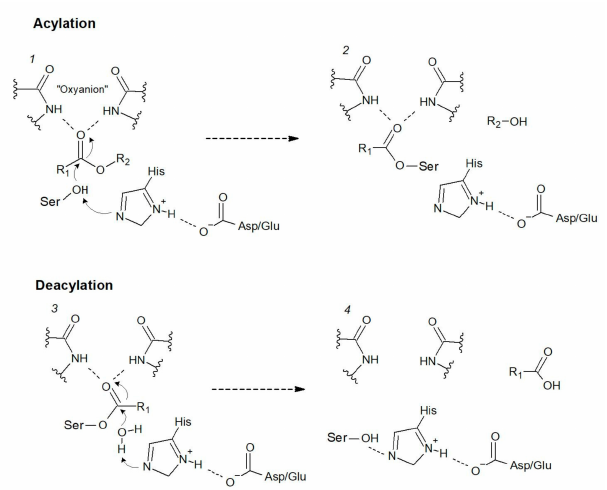
Figure 2. Schematic representation of the mechanism of hydrolysis reactions catalyzed by lipases. The catalytic triad (Ser-His-Asp/Glu) and the oxyanion group are shown, which are conserved structural features of lipases’ catalytic site (ACD/ChemSketch (Freeware) version 2018.2.1, Advanced Chemistry Development,